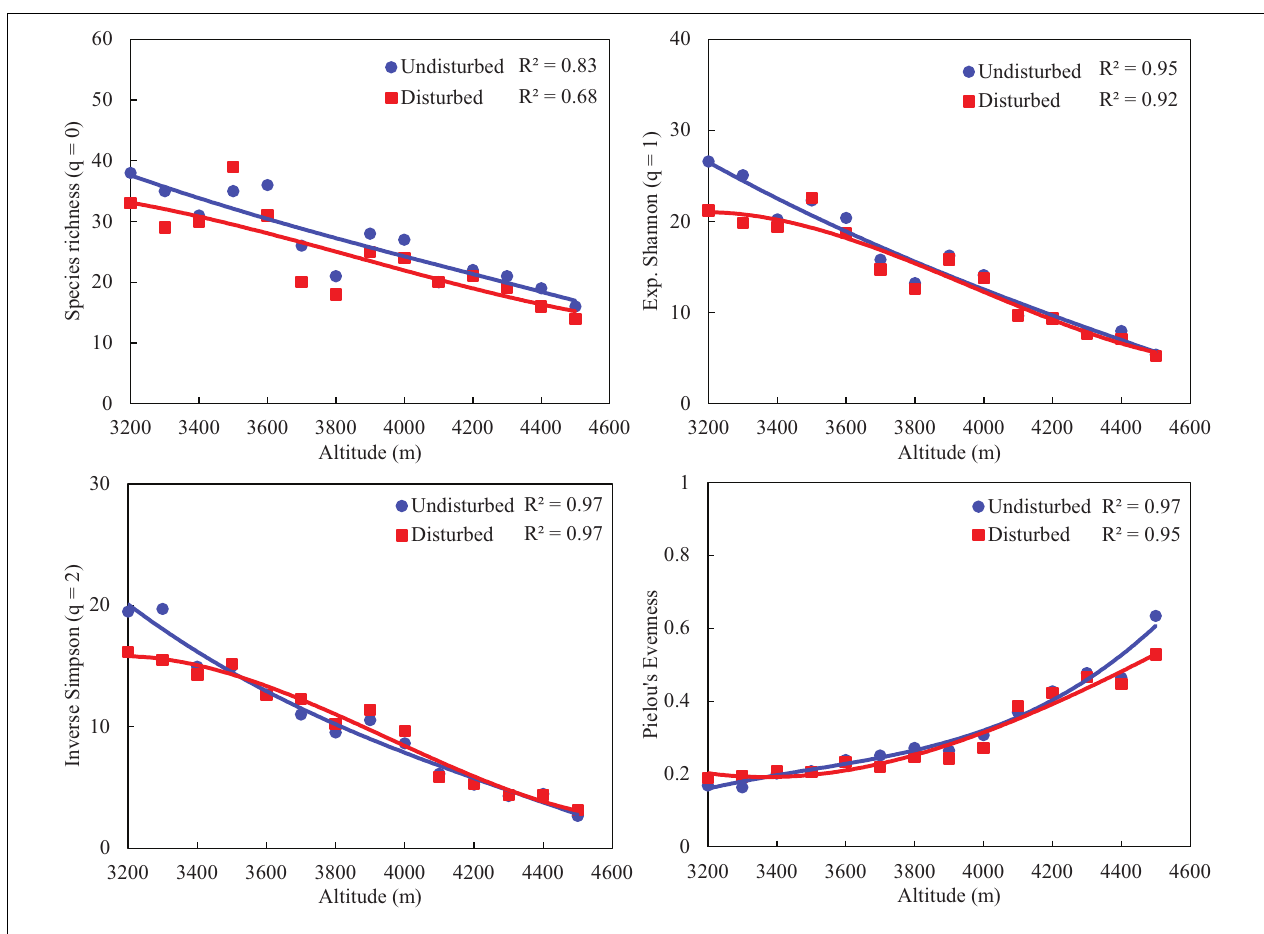
FIGURE 3 | Comparison of diversity (Hill numbers) profiles between disturbed and undisturbed sites along altitude gradients in GHNP.